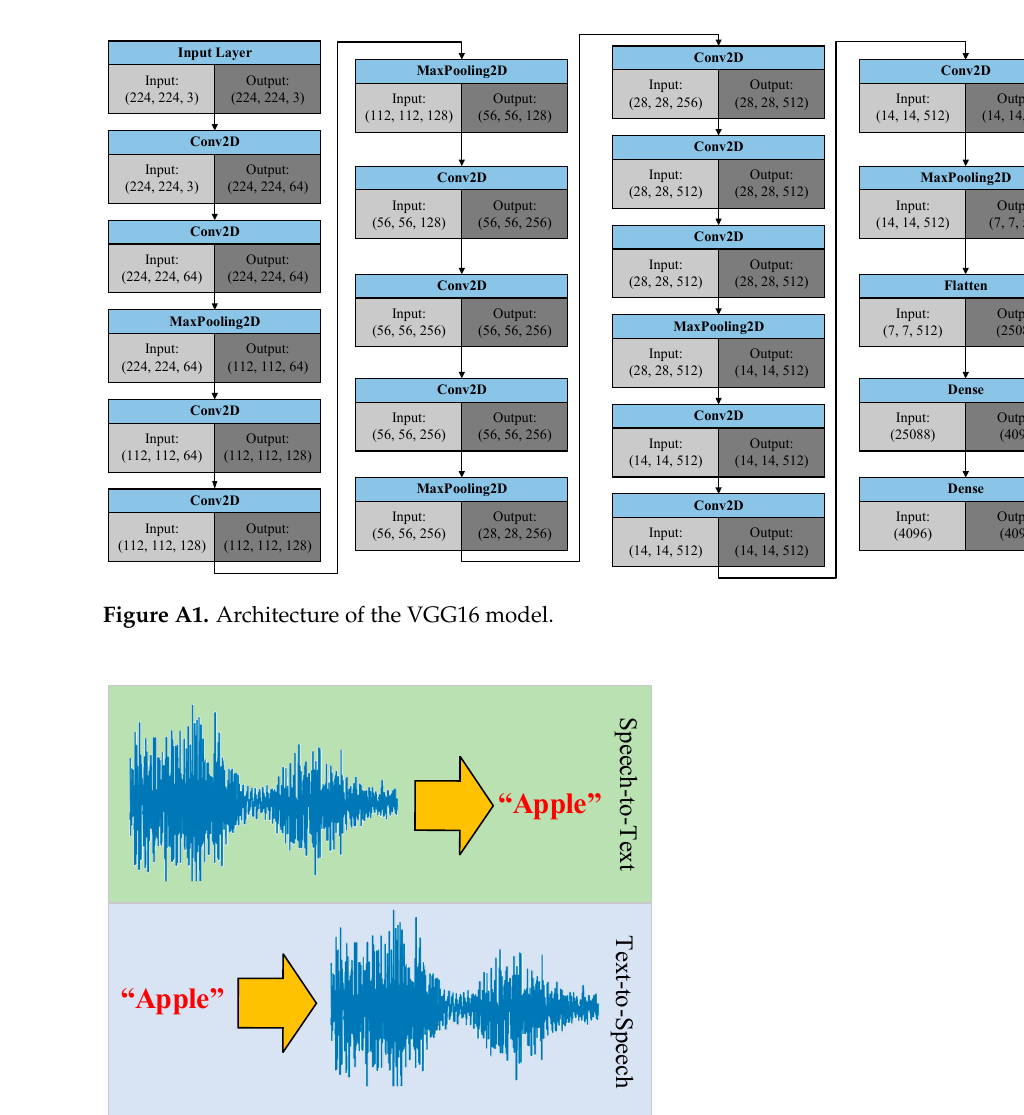
Figure A2. The process of Speech-to-Text and Text-to-Speech.